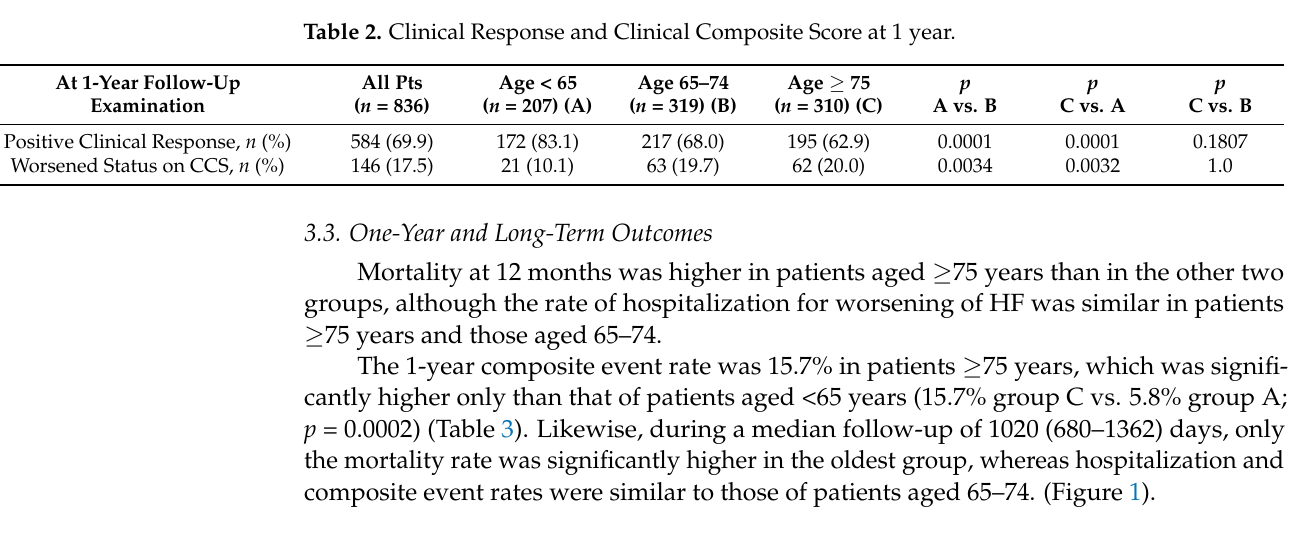
Table 3. Medium-term